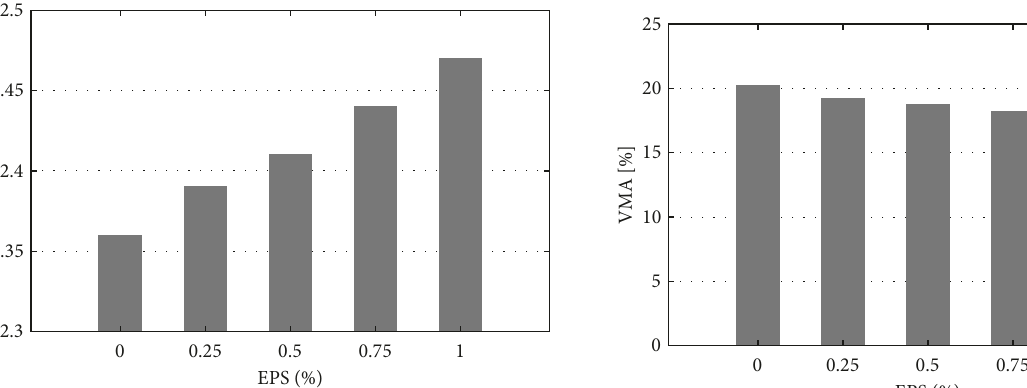
Figure 11: Relationship between density and